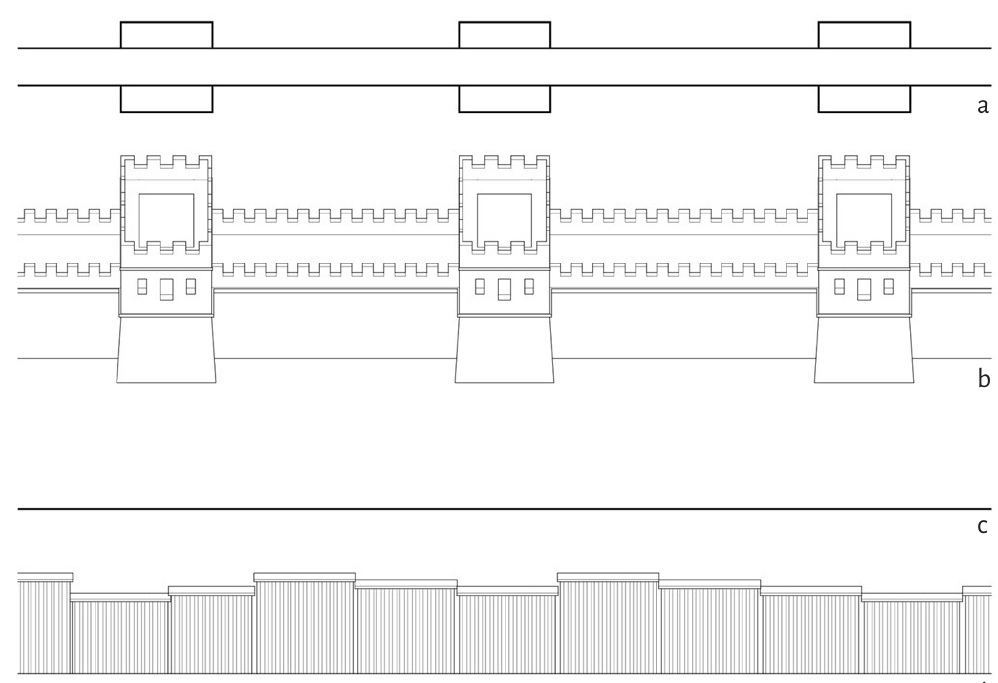
Fig. 5 Planimetric and axonometric diagram of Great Wall of China (a) and of Tijuana Wall